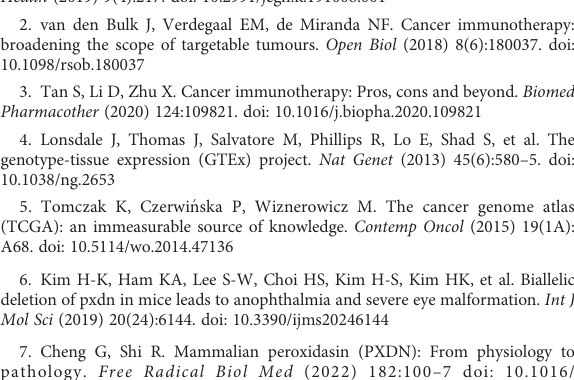
SUPPLEMENTARY FIGURE 4 GSEA results, based on PXDN-binding and correlated gene GO enrichment analysis